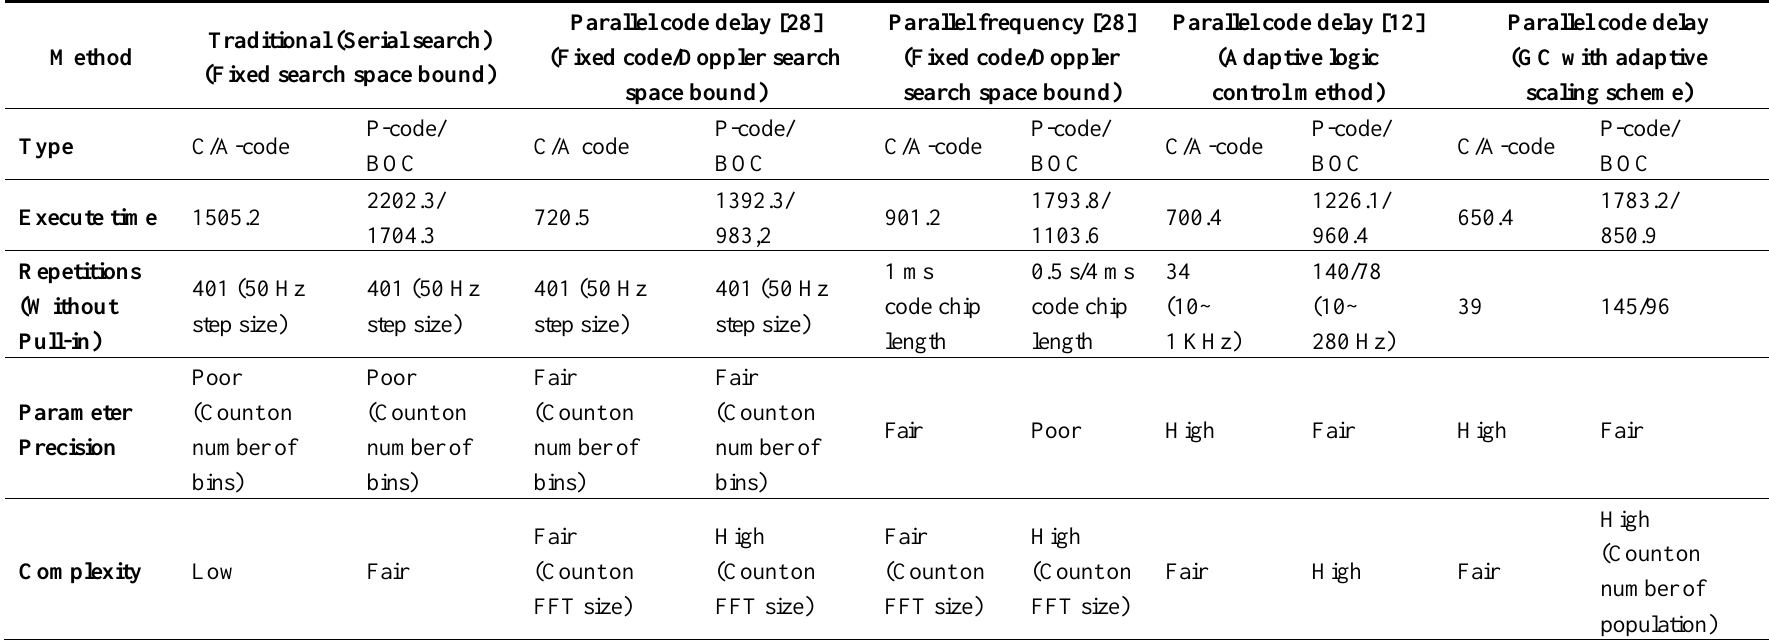
Table 1. Performance comparison of different acquisition methods